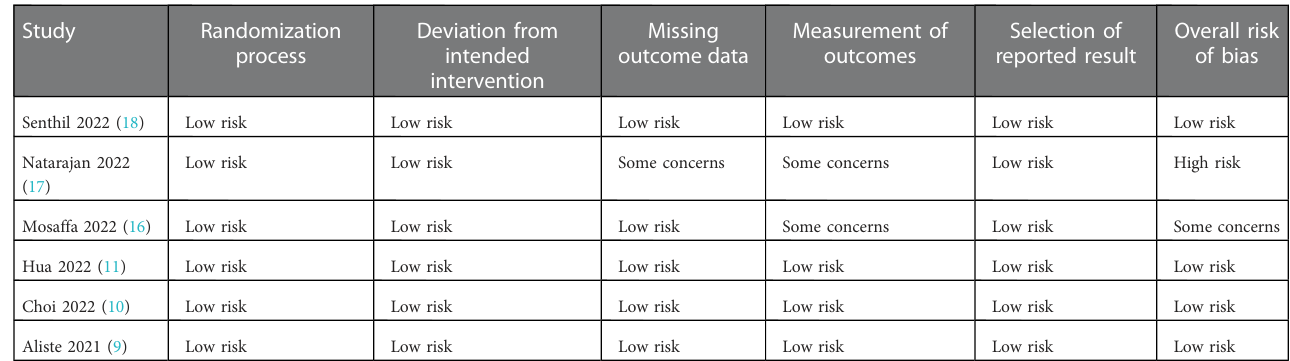
TABLE 3 Risk of bias in included